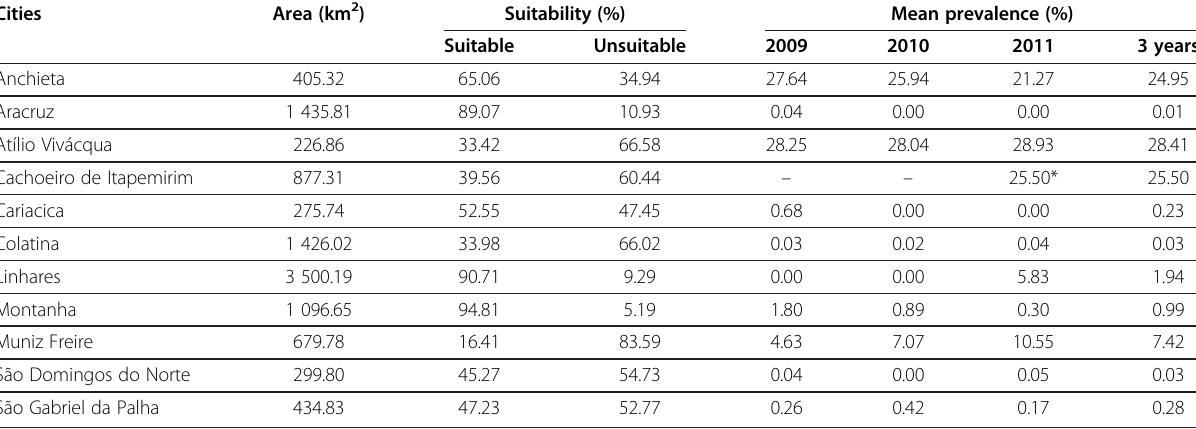
Table 2 Environmental suitability for bovine fasciolosis and its mean prevalence from 2009 to 2011 regarding distribution by counties in Espírito Santo state according to slaughter maps provided by the Institute of Agricultural and Forestry Defense of Espírito Santo State